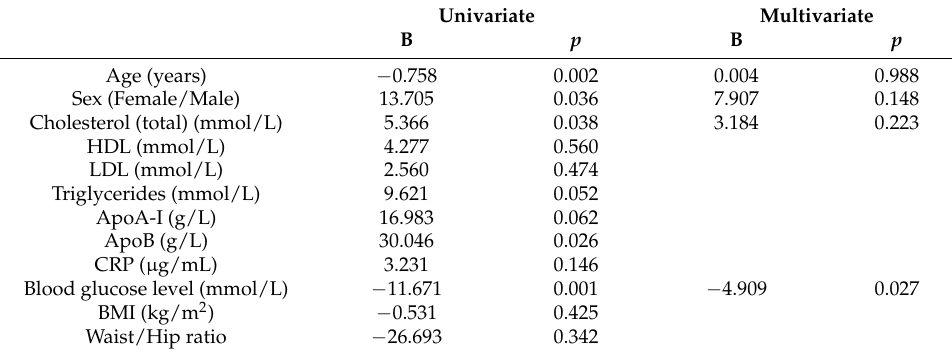
Table 4. Multivariate analysis with sUmod being the dependent variable.